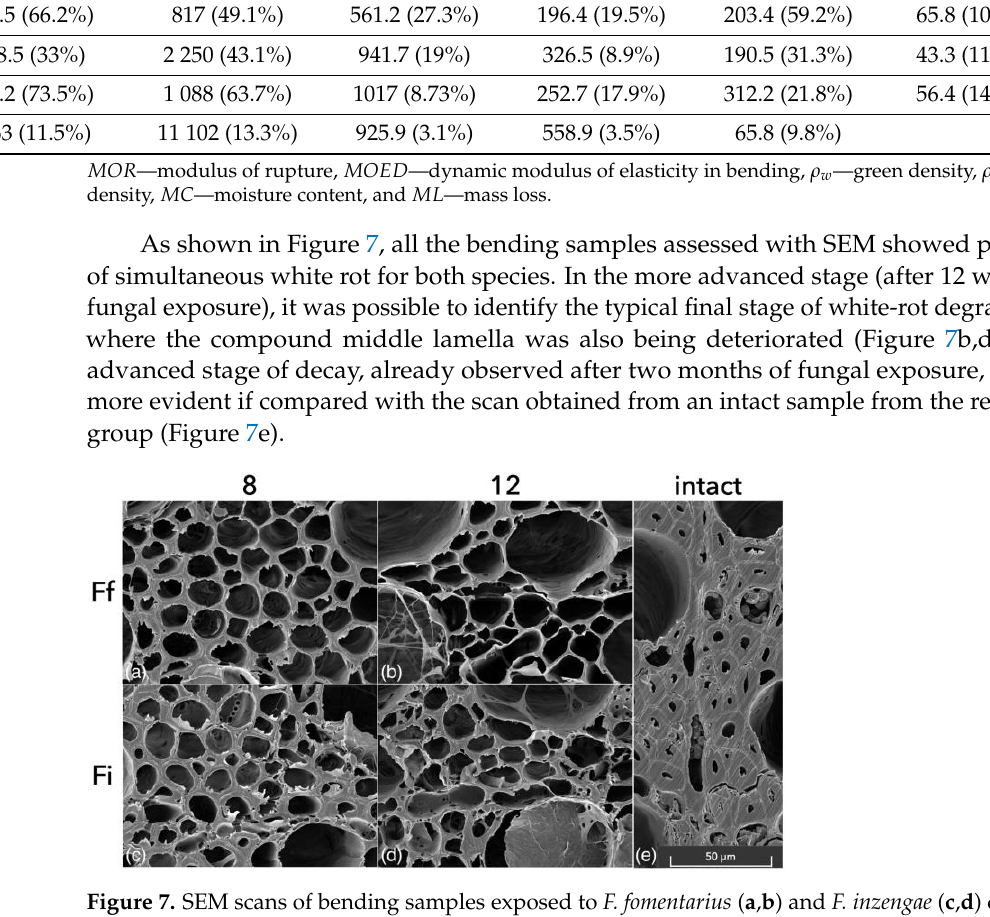
Figure 7. SEM scans of bending samples exposed to F. fomentarius ( a , b ) and F. inzengae ( c , d ) cultures; scan from intact bending sample ( e ). Numbers refer to the inoculation period in weeks. Larger high-quality images are available in Supplementary Materials (Figures